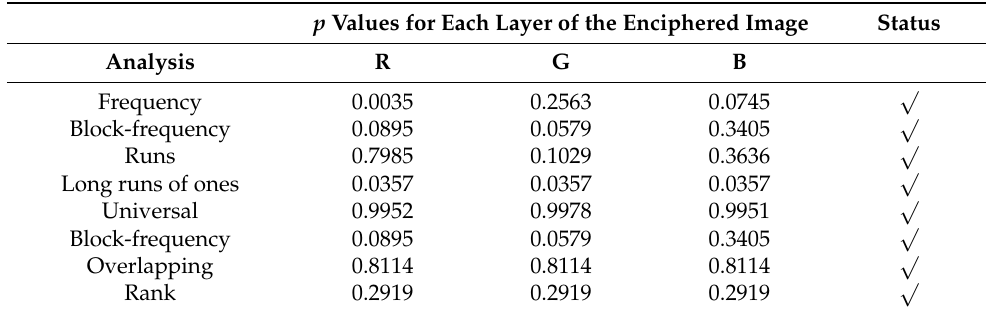
Table 6. NIST randomness measure for Tulip encrypted image.